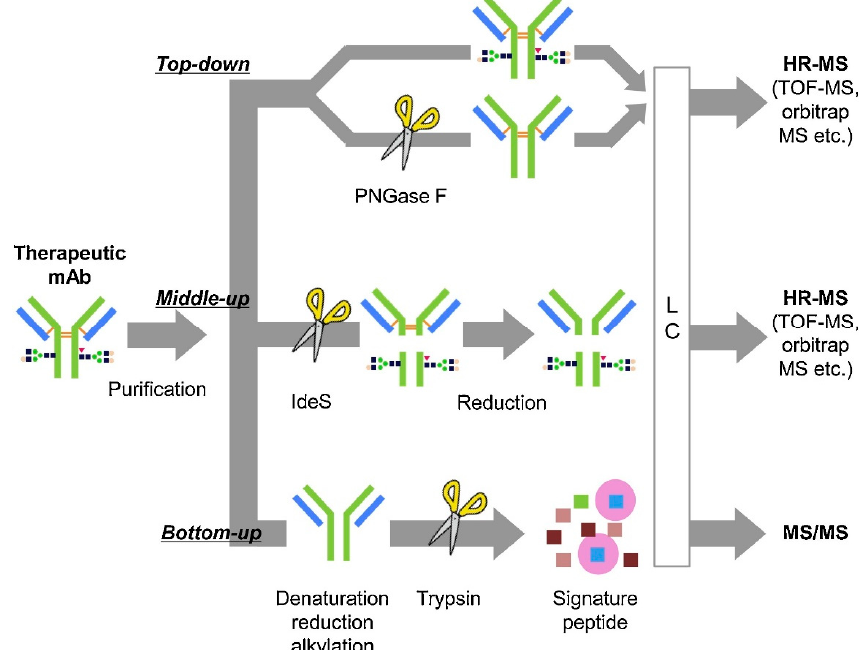
Figure 5. A workflow of bioanalysis for therapeutic mAbs by bottom-up, middle-up, and top-down approaches. Reproduced with permission from Todoroki et al. J. Pharm. Biomed. Anal. 2020, 179, 112991 [161]. Abbreviations: HR-MS, high resolution mass spectrometry; LC, liquid chromatography; MS, mass spectroscopy; MS/MS, tandem mass spectroscopy; TOF-MS, time of flight mass